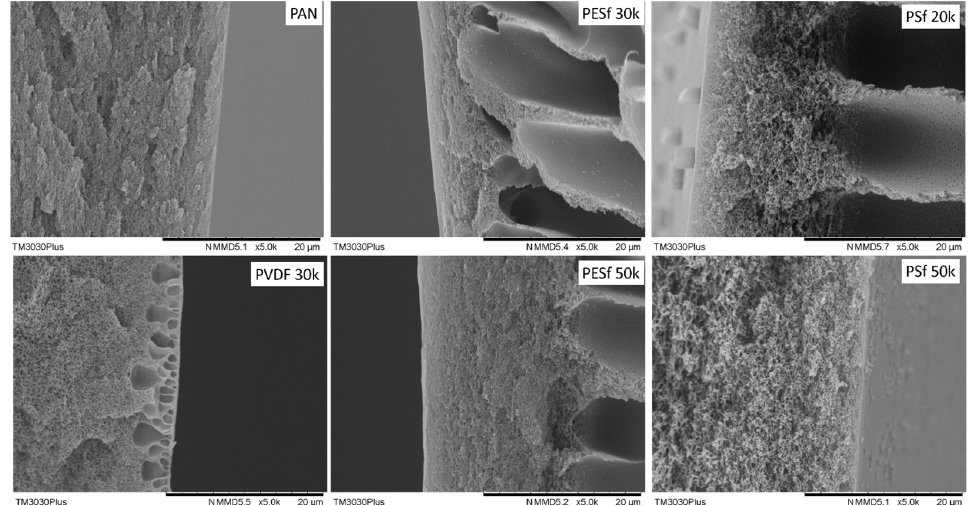
Figure 1. Cross-section of the 6 porous supports selected.